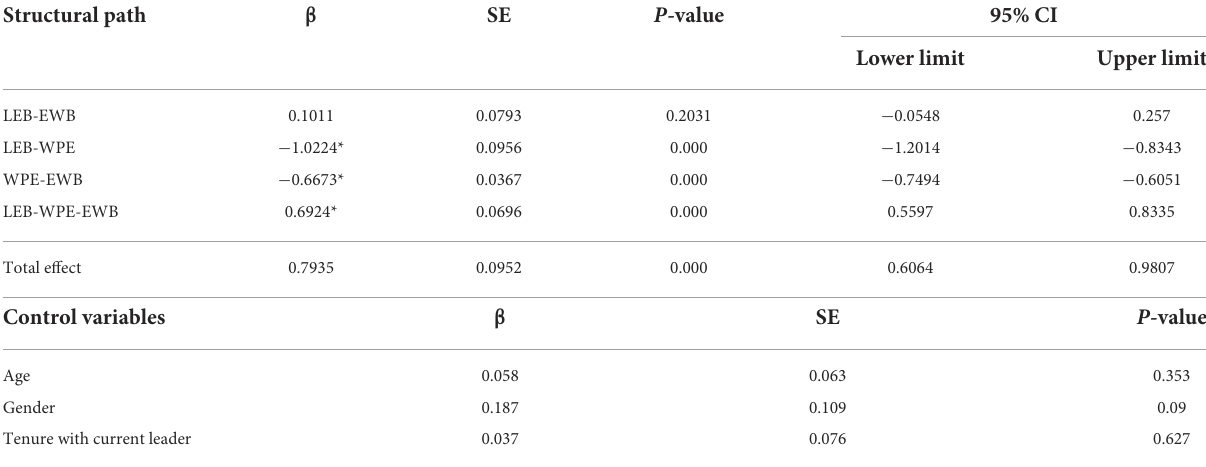
TABLE 5 Mediation model’s path coefficients and indirect